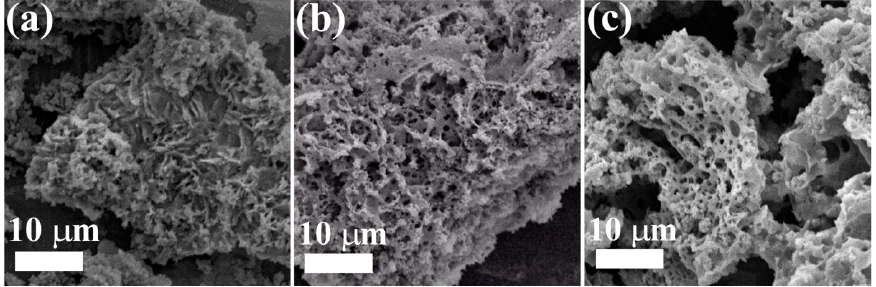
Figure 2. SEM images of the synthesized MgO samples MgO-Av ( a ), MgO-CP ( b ), and MgO-St ( c ).